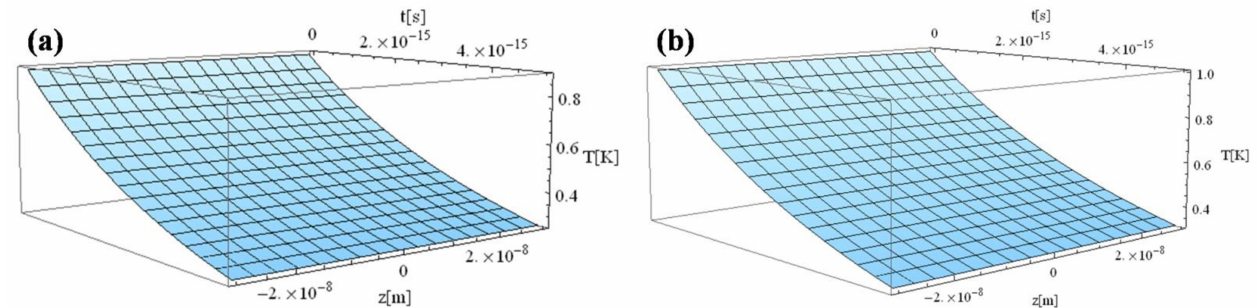
Figure 2. Electron temperature versus time and z during 1 fs simulation after irradiation with a 100 as laser pulse applied to an Au nanoparticle: ( a ) 40 × 20 × 30 nm 3 rotation ellipsoid; ( b ) 30 nm radius sphere.